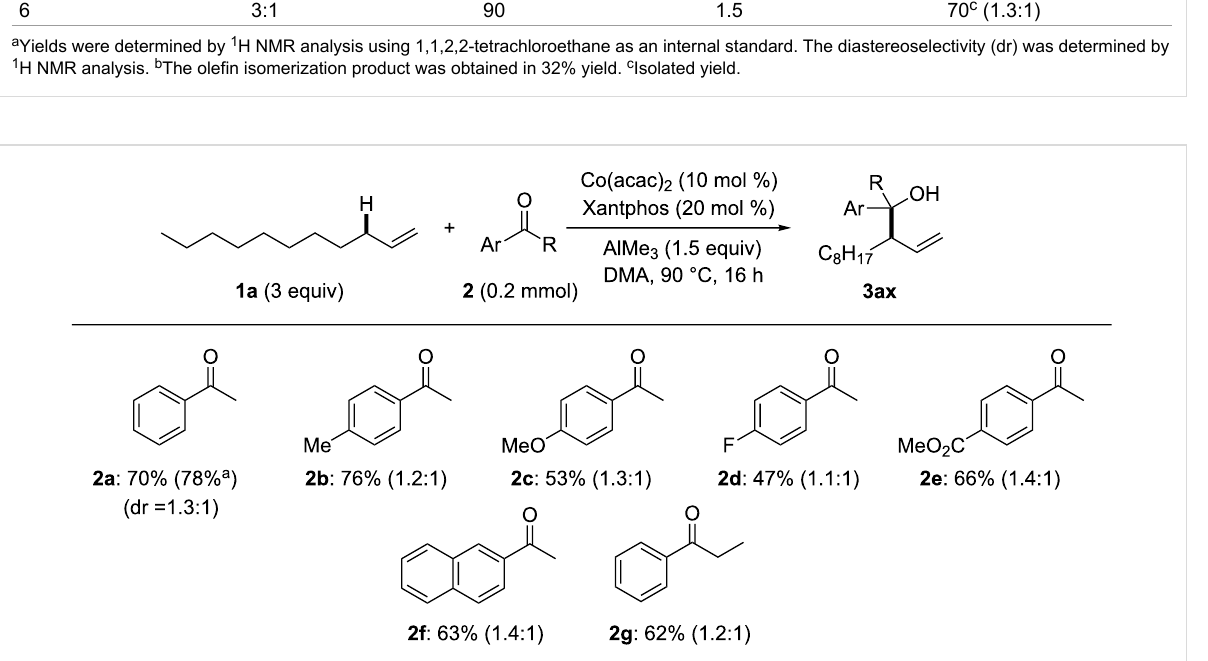
60% yield. However, p -CF 3 -acetophenone (18%), acetone (14%), cyclohexanone (29%), and benzophenone (25%) were not suitable substrates for C(sp 3 )–H addition of 1a (figures not